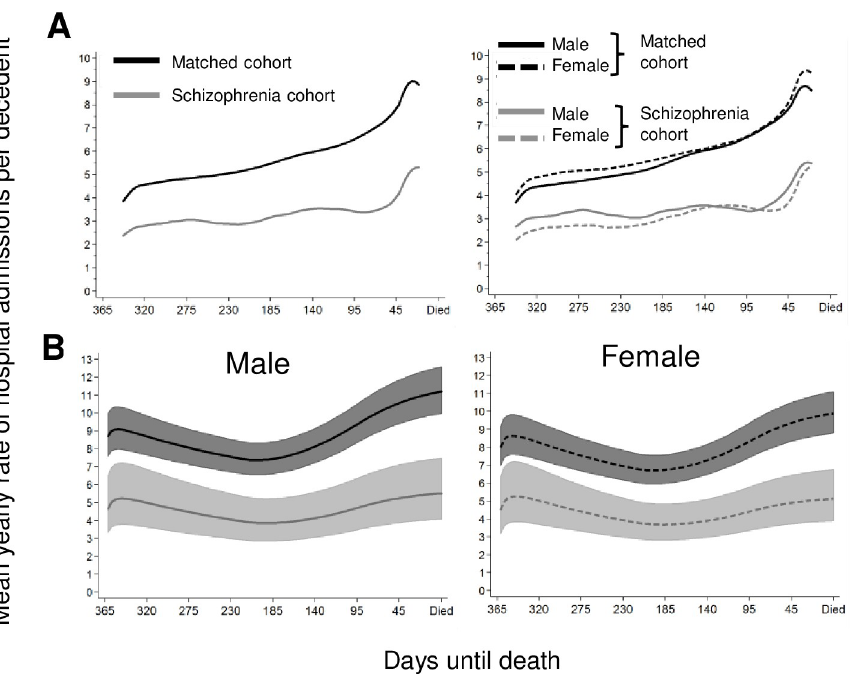
Fig 2. The average yearly (hazard) rate of hospital admissions per decedent over the last year of life for the schizophrenia and matched cohorts and stratified by sex estimated from A) an unadjusted kernel-weighted estimator of the hazard and B) a flexible parametric proportional hazards model adjusted for age at death, comorbidity, socioeconomic status, accessibility index, sex, partner status, indigenous status and country of birth. Hazard rates and 95%CI in B are those predicted for Australian born non-Indigenous decedents living in a metropolitan area of average disadvantage without a partner, aged 50 years or older at death and with three comorbid